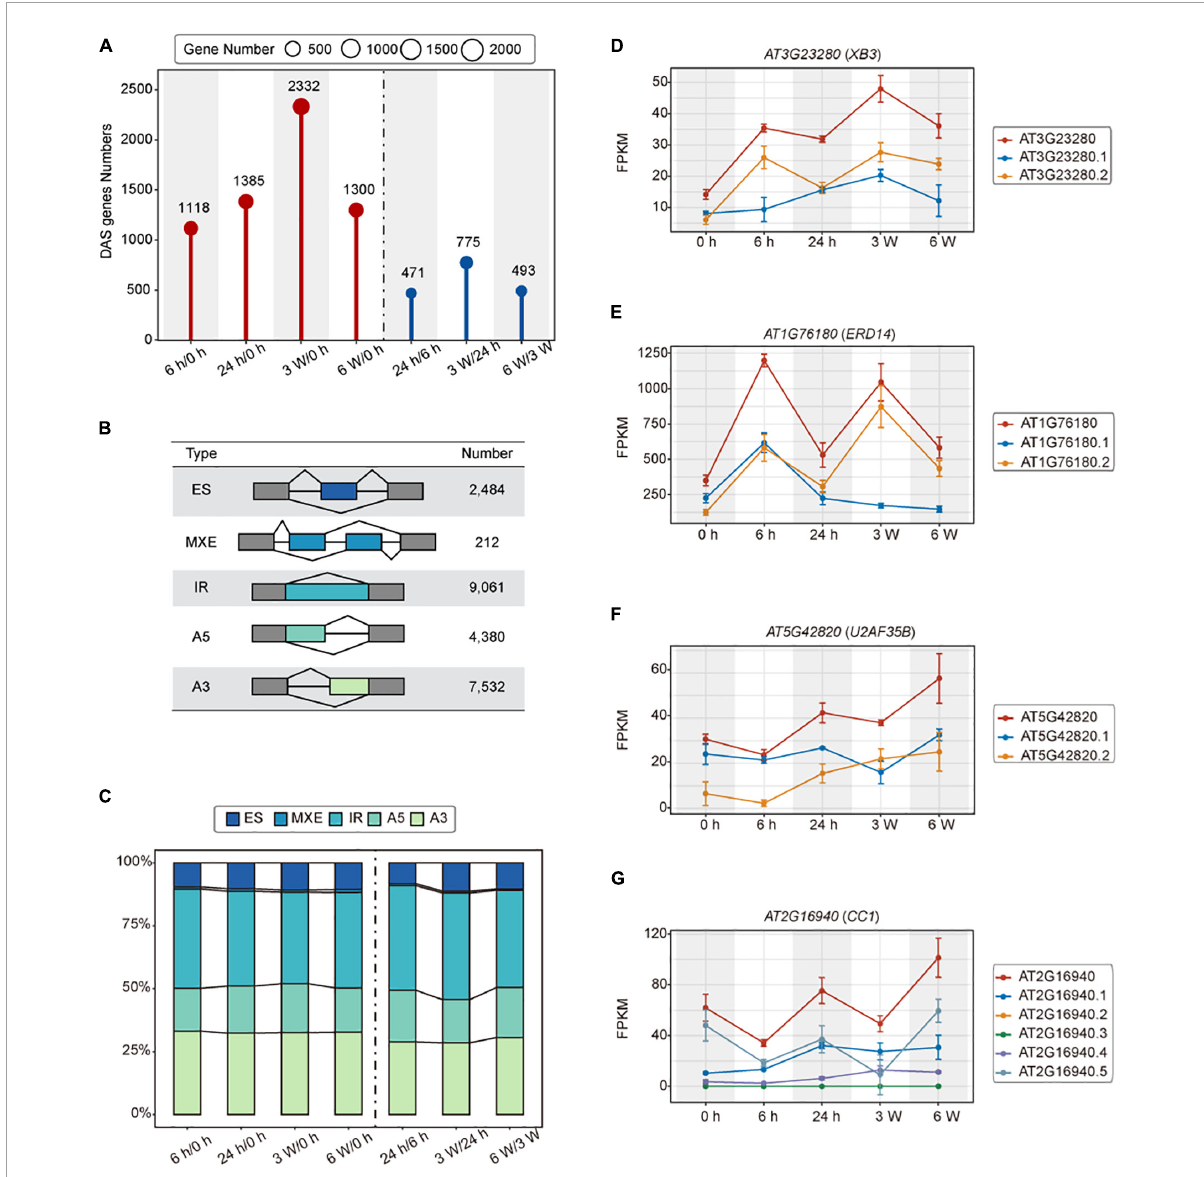
FIGURE3 Alternative splicing of the transcriptomes of FRI-Col in different times of cold treatment. (A) Identified differentially alternatively spliced (DAS) genes in the Arabidopsis transcriptome during cold treatment. (B) Summary table of AS events detected by the IsofromSwitchAnalyzeR. Exon skipping (ES), Mutually exclusive exon and multiple Exon Skipping (MXE), Alternative 5’ splice site (A5), Alternative 3’ splice site (A3), and intron retention (IR). (C) Stacked bar charts showing the AS events percentage at each pairwise time point. Line charts showing the ES, IR, A5, and A3 events in (D–G)